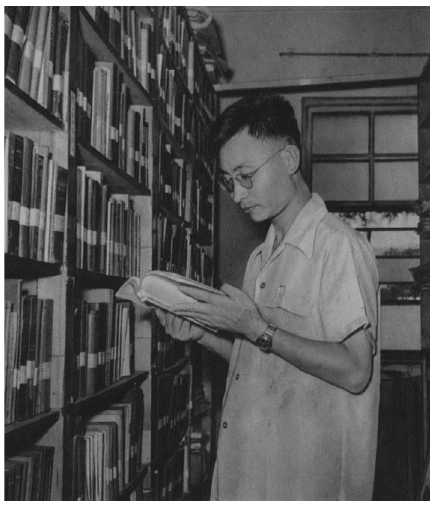
Figure 2. Jia-Xiang Shen was searching documents for chloramphenicol at a library (1957).